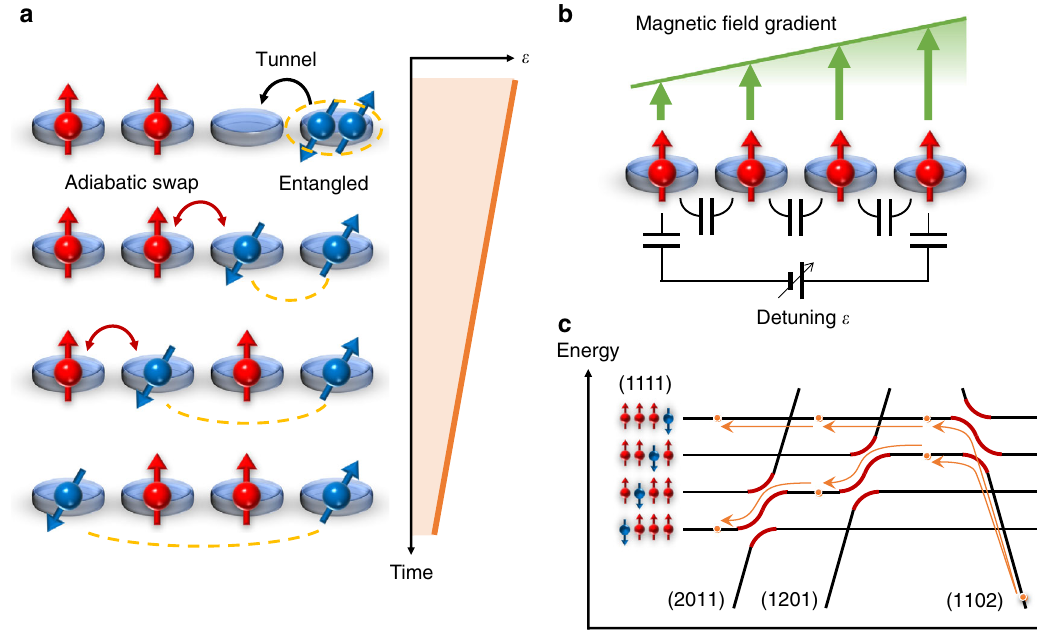
Fig. 1 Entanglement shuttling in a spin chain. a Schematic of transferring an entangled state with a linear ramp of detuning energy ε in an array of four spin qubits as an example. Note that the experiment described below is performed in an array of three spins, which is the minimum setup for demonstrating the concept. b Typical experimental setup of the spin array. The magnetic fi eld gradient is prepared for addressable control of spin qubits by, e.g., a micromagnet 8 – 10 . A gate bias voltage applied between both ends of the array makes an electrostatic potential gradient via capacitive coupling. c Energy diagram corresponding to the setup shown in b . Such a con fi guration is realized when, e.g., the electrostatic energy differences between neighboring dots are equally modulated by ε /3 and each potential has a proper energy offset. Orange arrows show the adiabatic state transitions for the entanglement transfer and orange circles indicate two superposed states at each